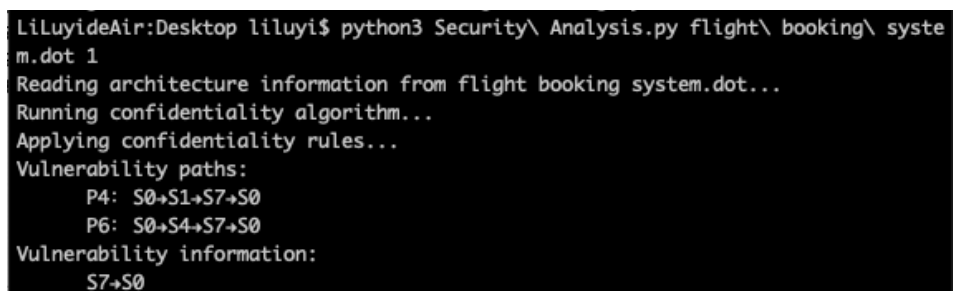
Figure 8. Service invocation diagram of network reception and dispatch module.